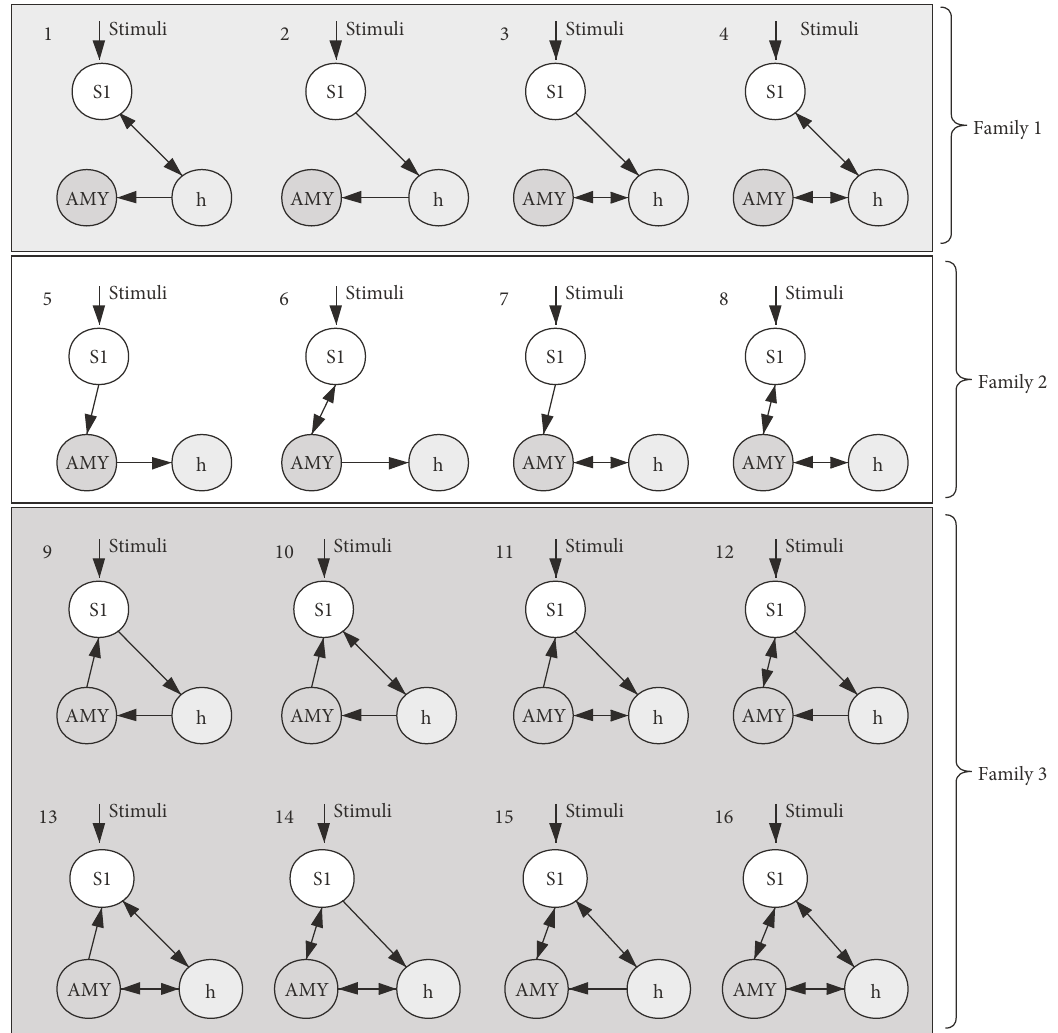
Figure 1: Framing of dynamic casual model (DCM) structures. 16 dynamic causal modeling structures were de fi ned as the common stimuli (i.e., driving input) but with di ff erent e ff ective connectivity (i.e., propagation pathway); therefore, they were divided into 3 families. 3 ROIs (i.e., ROI S1 =somatosensory cortex, ROI AMY=amygdala, and ROI h =hypothalamus) were speci fi ed in the models from the left